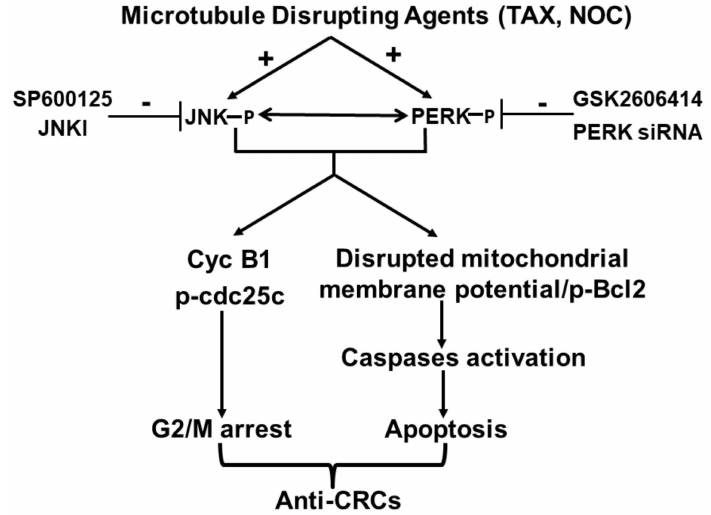
Figure 8. A tentative mechanism for anti-CRC actions of the microtubule-disrupting agents TAX and